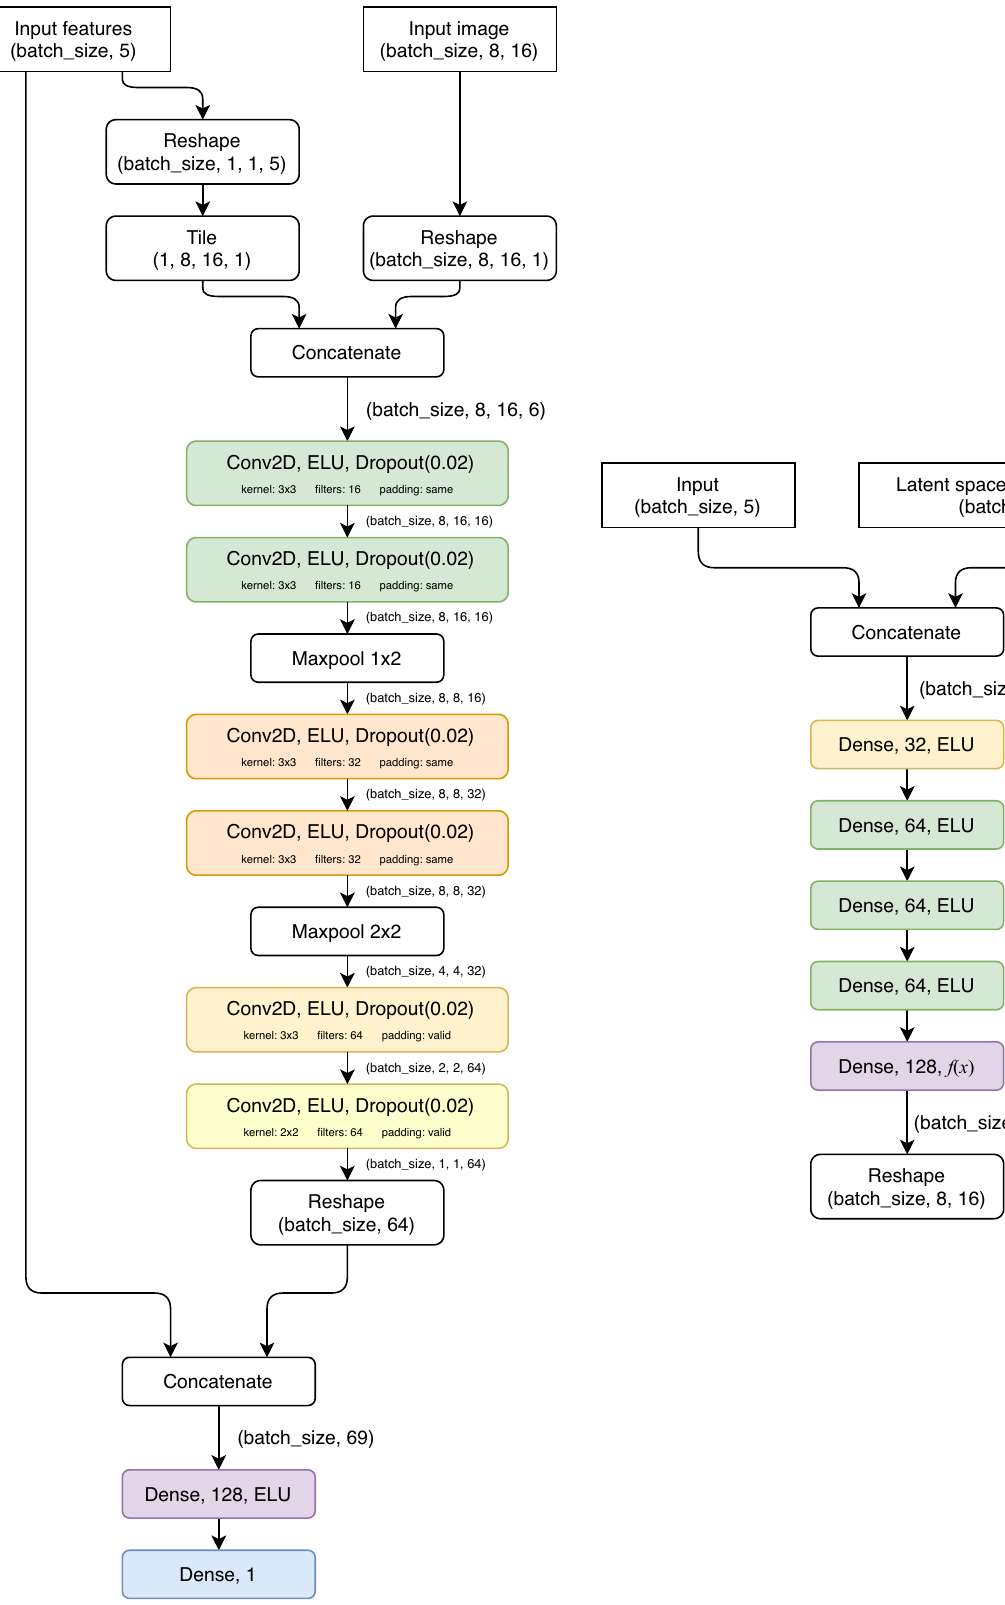
Fig. 9 Neural network architecture for the discriminator (left) and the generator